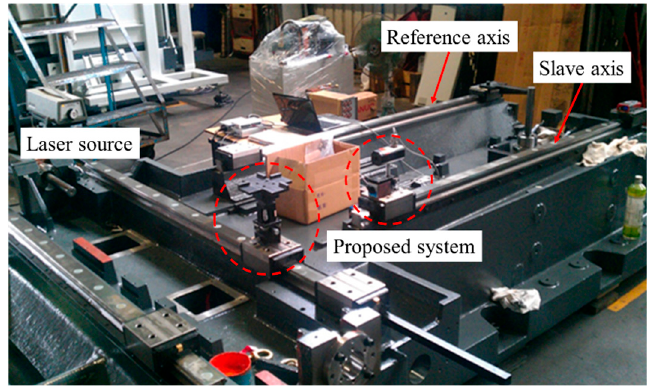
Figure 23. Case 4 parallelism error measurement setup.